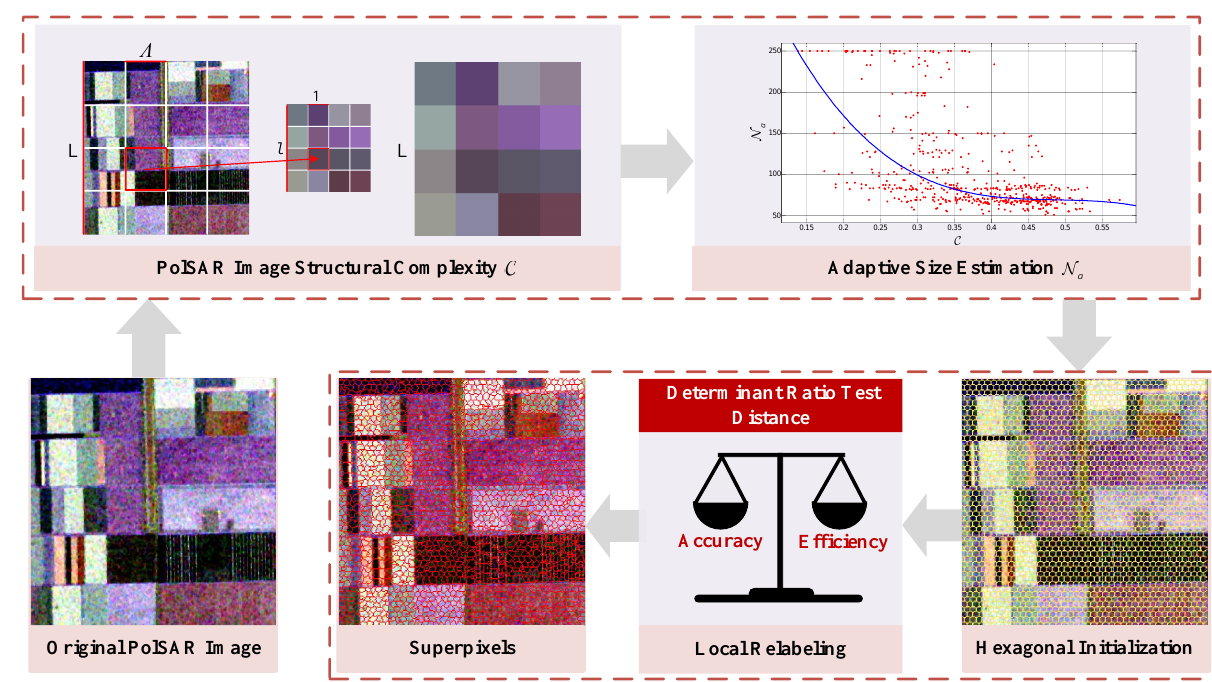
Figure 1. An overview of the proposed